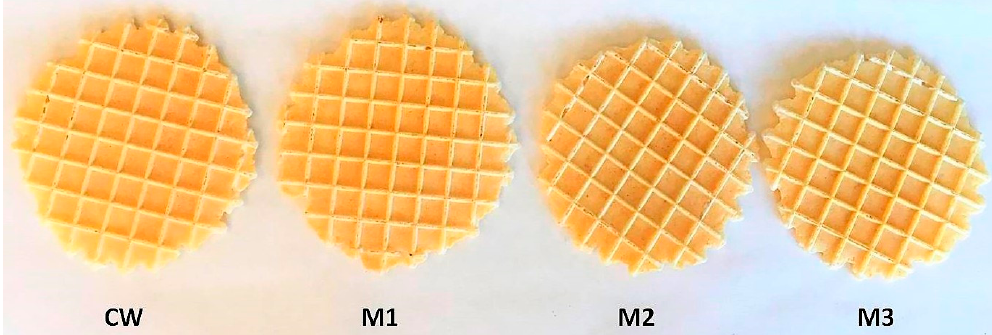
Figure 1. Wheat wafers (CW) with addition of millet grain flour (1%, 2%, 3%; M1, M2, M3, respectively).